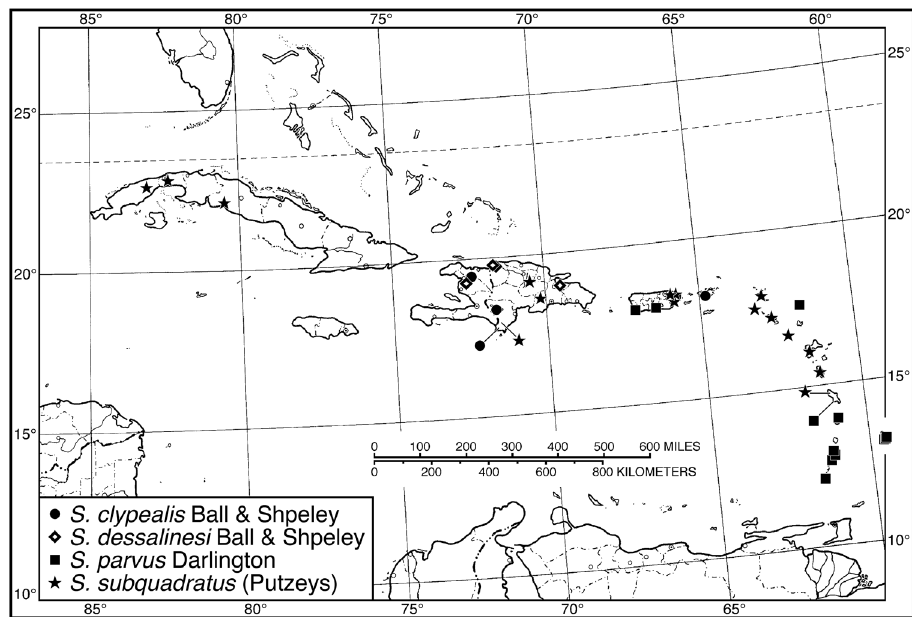
Figure 30. Map of West Indies showing known localities for species of Selenophorus hylacis species group.